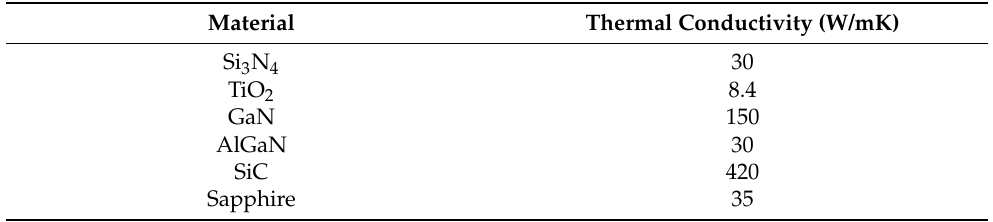
Figure 1. Schematic cross-section of a recessed-gate GaN MOSFET based on AlGaN/GaN heterostructure with TiO 2 and Si 3 N 4 as dual-layer insulator. Table 1. Thermal conductivity at 300 K of materials used in the proposed recessed-gate GaN MOSFET [19–22].